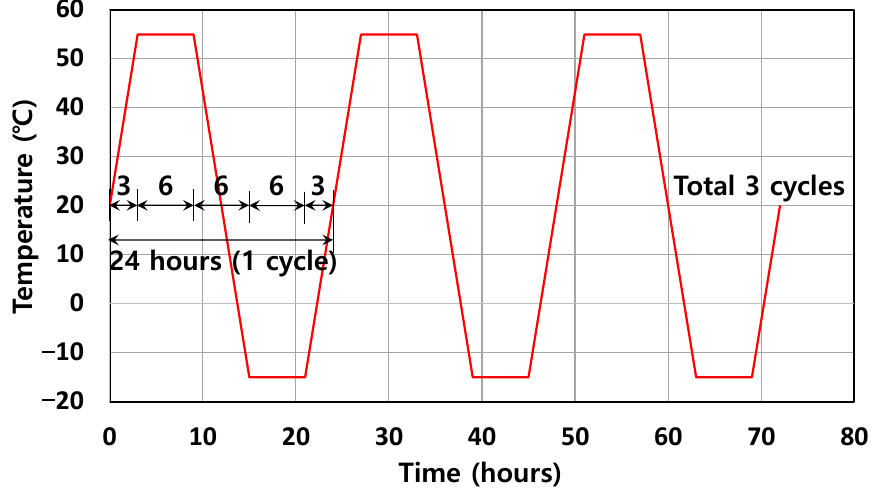
Figure 5. Temperature history inside the chamber.